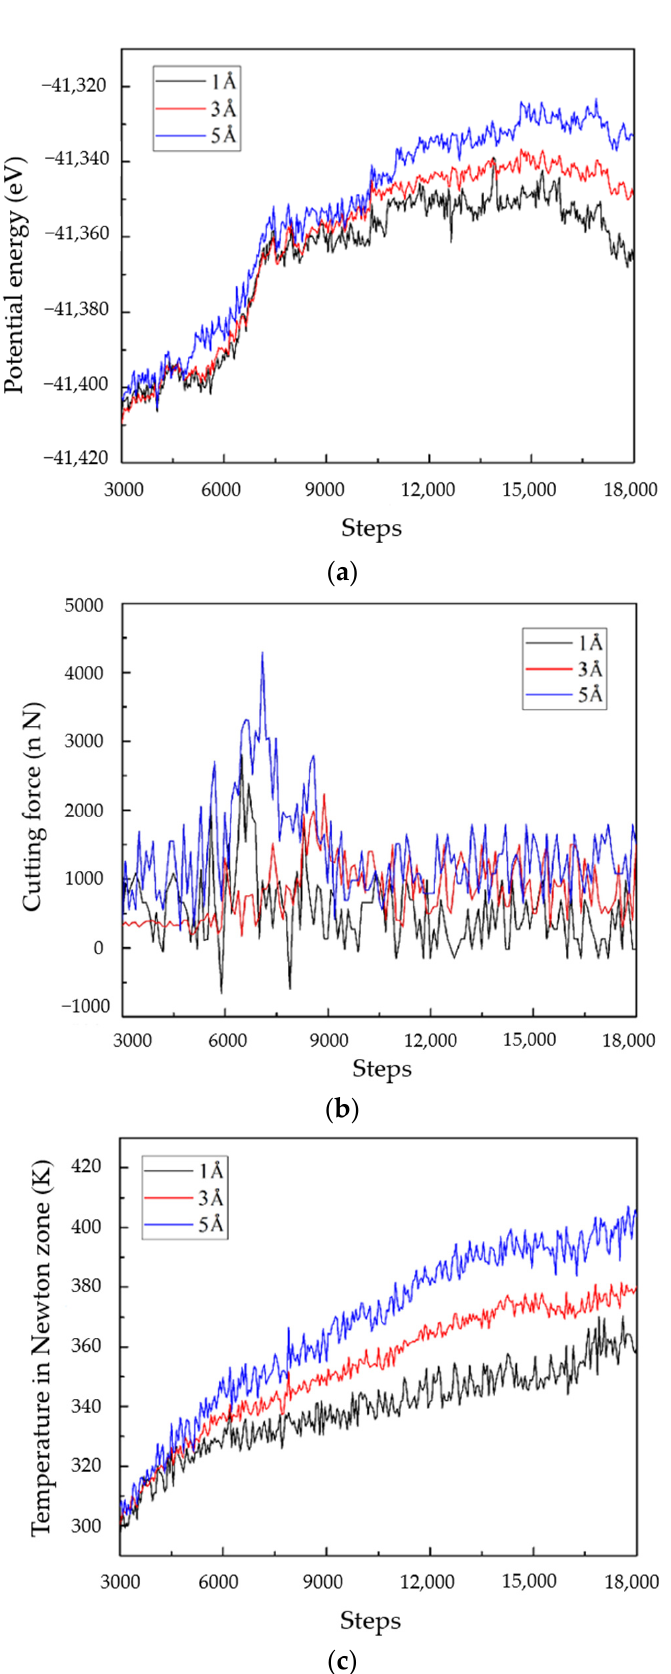
Figure 6. The effect of abrasive particle radius on different physical quantities during the cutting process: ( a ) potential energy, ( b ) cutting force, ( c) temperature in Newton zone.